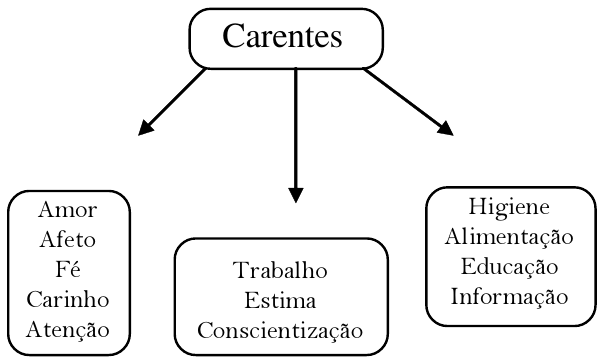
Figura 1. Características das famílias a partir da percepção dos agentes comunitários de saúde. Portanto, é fato que todos os agentes reconhecem as dificuldades que estas famílias enfrentam. Apesar disso, parece prevalecer uma visão determinista e negativa (pelo número de “nãos” e indicações de “ausências de”) com predomínio da percepção da carência, da falta de “alguma coisa”. Além disso, os profissionais fazem refe- percebida como transmissível de geração para